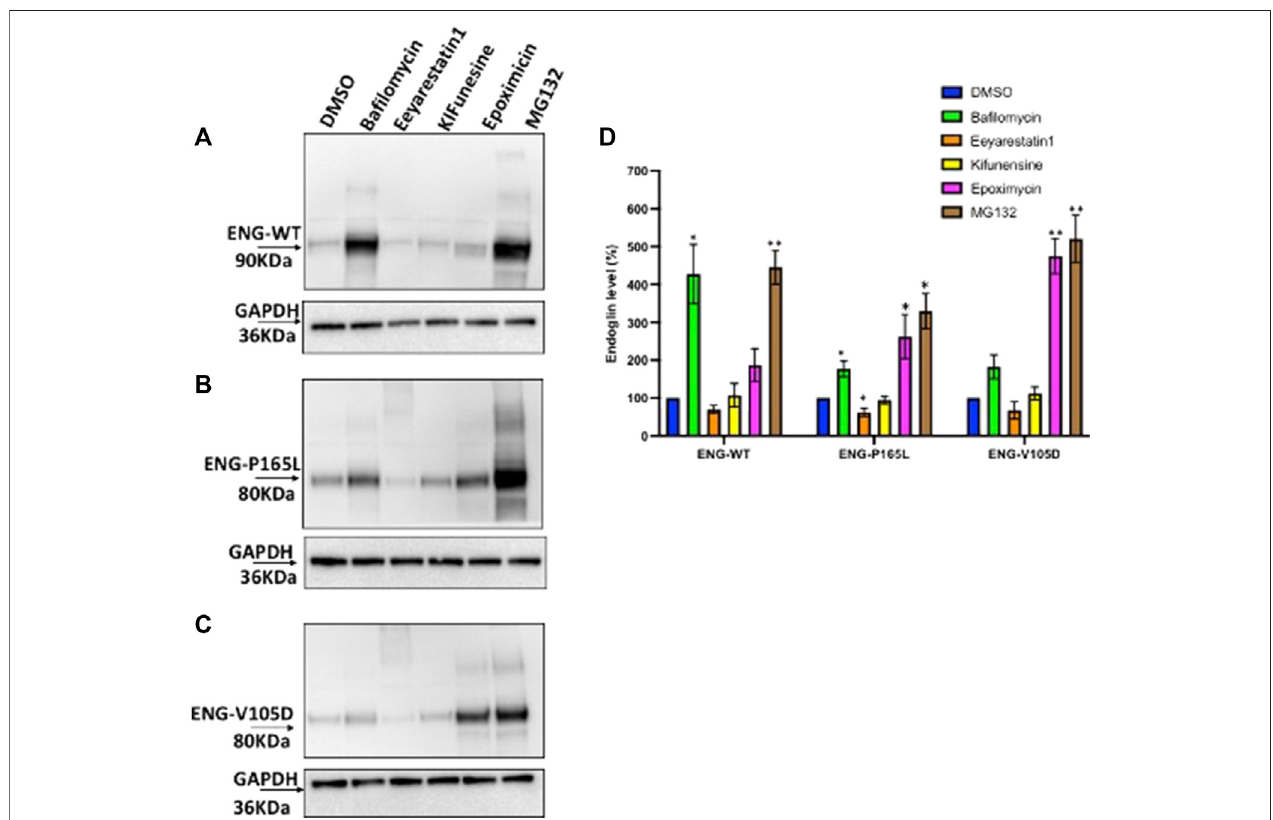
FIGURE 5 | Degradation pathway of WT and mutant Endoglin P165L and V105D. (A – C) Stable HEK293 cell lines harboring the HA-tagged ENG-WT and mutant variants p. P165L and p. V105D were treated with Ba fi lomycin (200 nM) (lysosomal inhibitor), Eeyrestatin I (5 μ M) and Kifunesine (50 nM) (ERAD inhibitors), MG132 (10 μ M), and Epoximycin (100 nM) (proteasomal inhibitors). Total cell lysate was analyzed by immunoblotting against antibodies for HA- ENG and GAPDH. (D) Bar graphs representing mean densities of WT Endoglin and mutants normalized with GAPDH. Endoglin level was expressed in (%) relative to DMSO treated (control). Bars represent SEM from 4 different Experiment ( n = 4). Statistical signi fi cance for each treatment relative to control was assessed using one sample t test, (*) p ≤ 0.05; (**); p ≤ 0.01; (***) p ≤